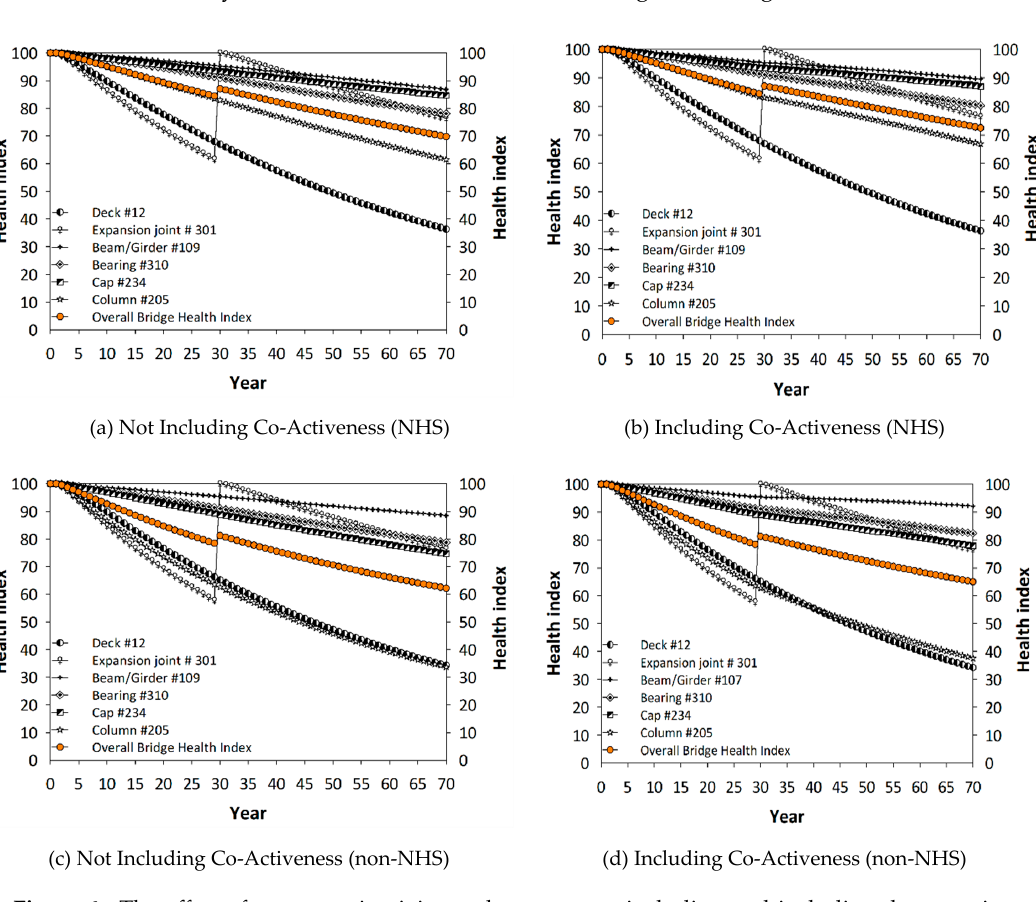
Figure 6. The effect of an expansion joint replacement not including and including the co-active mechanism: ( a ) and ( b ) in NHS bridges, ( c ) and ( d ) in non-NHS bridges in Georgia.